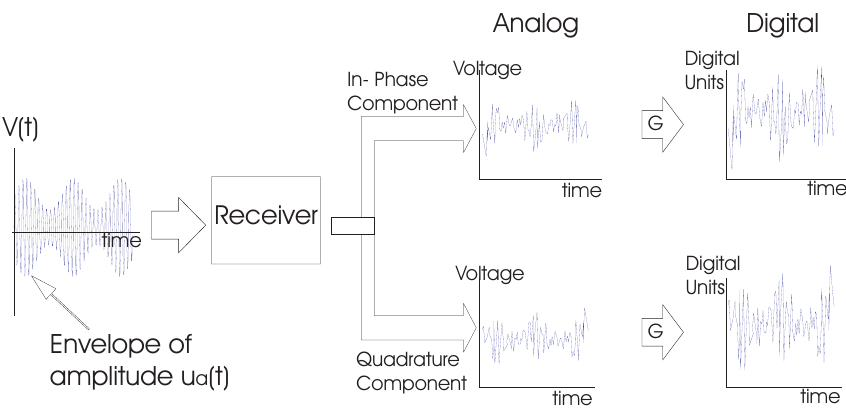
Fig. 1. A block diagram shows that a signal which is applied to the receiver as an input, goes through various stages before it becomes a spectrum. The input signal is first converted into in-phase and quadrature components in the receiver. The two components are then pre-amplified, and converted into digital form by the “system voltage